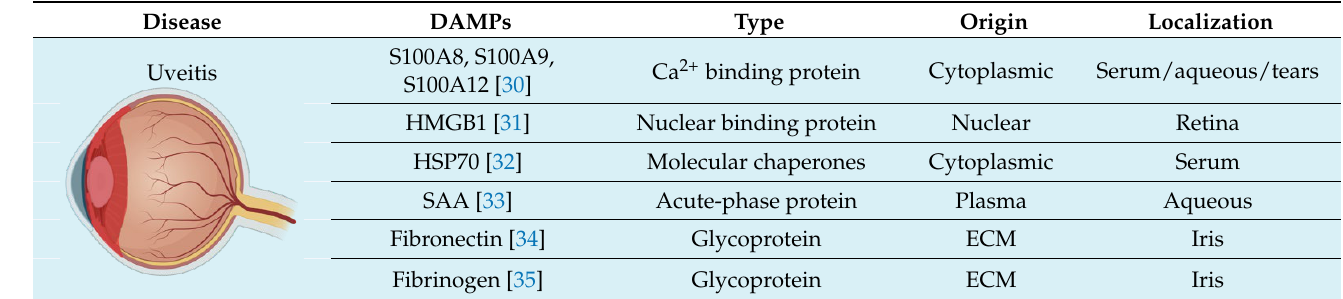
Table 2. DAMPs in uveitis.